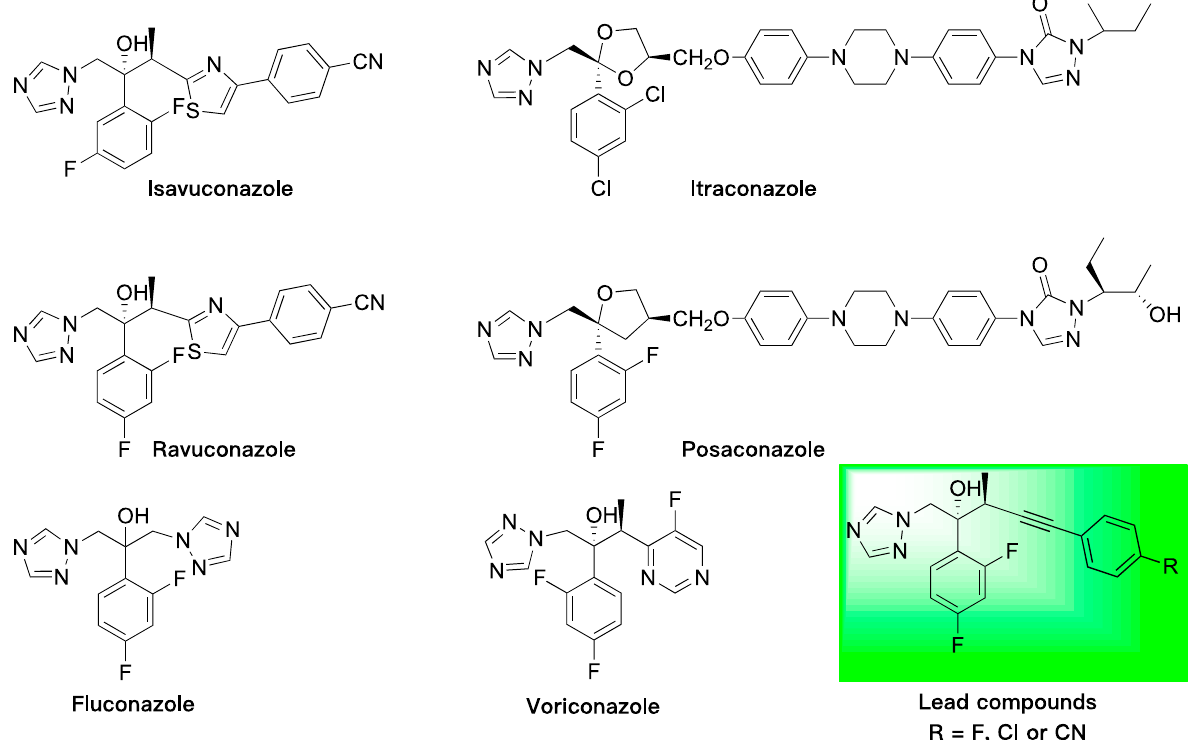
Figure 1. Several triazole drugs for IFIs in clinic and the structures of our lead compounds. Guided by the binding modes of triazole antifungal agents, a number of new triazoles were rationally designed and synthesized by our group [14–18]. Among them, a series of triazoles containing alkynyl side chains showed good antifungal activity with a broad spectrum [18]. They exhibited superior activity to fluconazole and comparable activity to voriconazole, and specially compound A5 (Figure 2) was subjected to evaluate its in vivo efficacy as a promising compound. Unfortunately, it possessed inferior activity in the murine model of disseminated C. albicans infection. Considering the lack of hydrogen bond donors and acceptors as well as the number of rotatable bonds in compound A5 , further lead optimization was focused on ameliorating drug-likeness in order to improve the in vivo potency. Herein, a series of novel side chains of triazole antifungals were de- signed by hybridizing the side chains in lead compound A5 and fluconazole and replacing the 1,2,4-triazole with pyrazole based on the bioisosterism principle [19] to construct a phenylethynyl pyrazole side chain in Figure 2. Herein, we reported in vitro antifungal activity and SAR of all the target compounds 5a–v and 6a–e , and in vivo antifungal potency of 6c